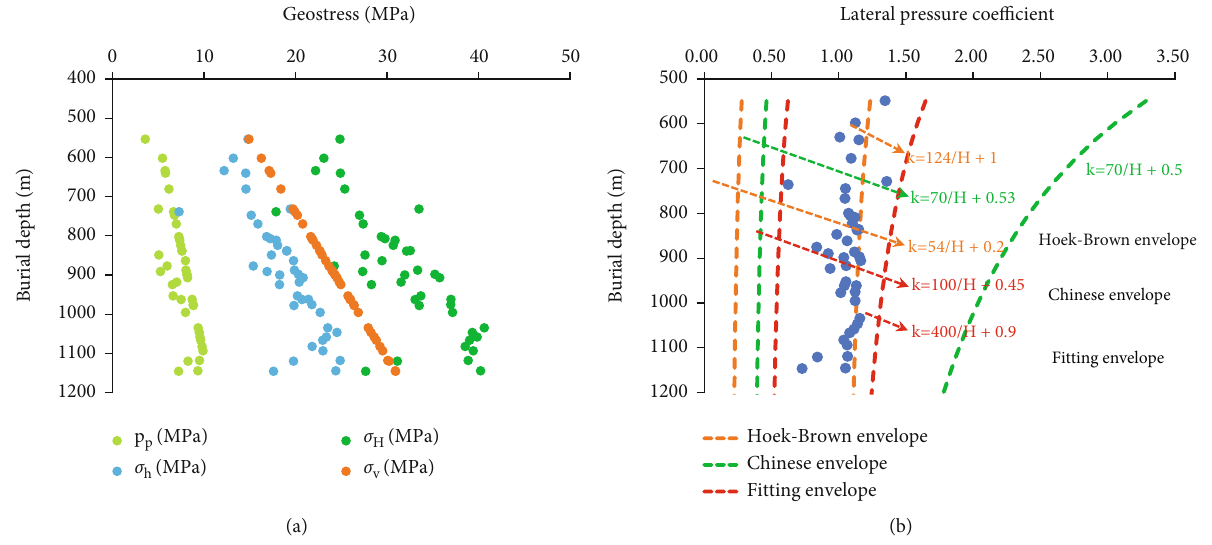
Figure 9: Characteristics of the variation of geostress with depth. (a) Di ff erent stresses versus depth of burial and (b) lateral pressure coe ffi cient versus depth of burial.